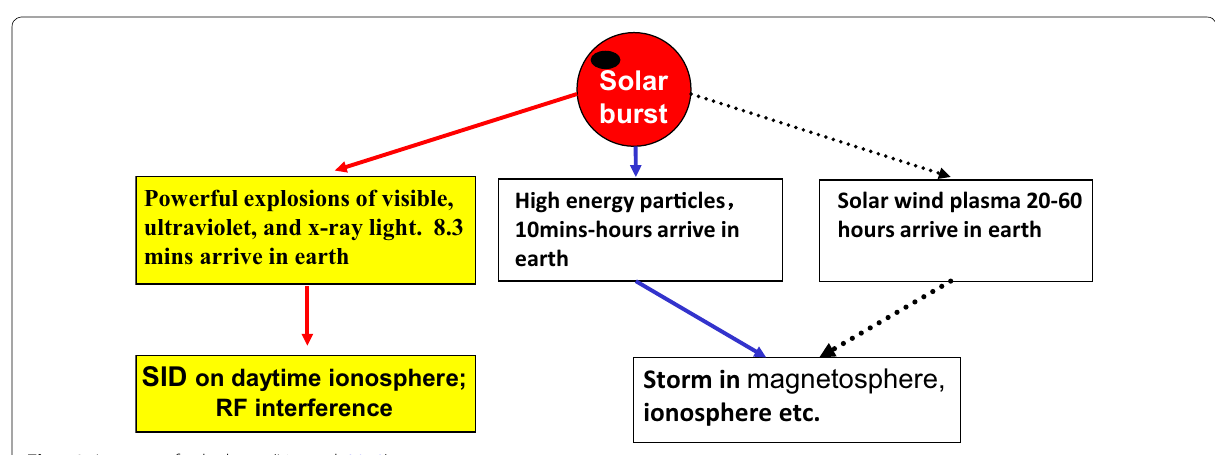
Fig. 12 Impacts of solar burst (Liu et al.